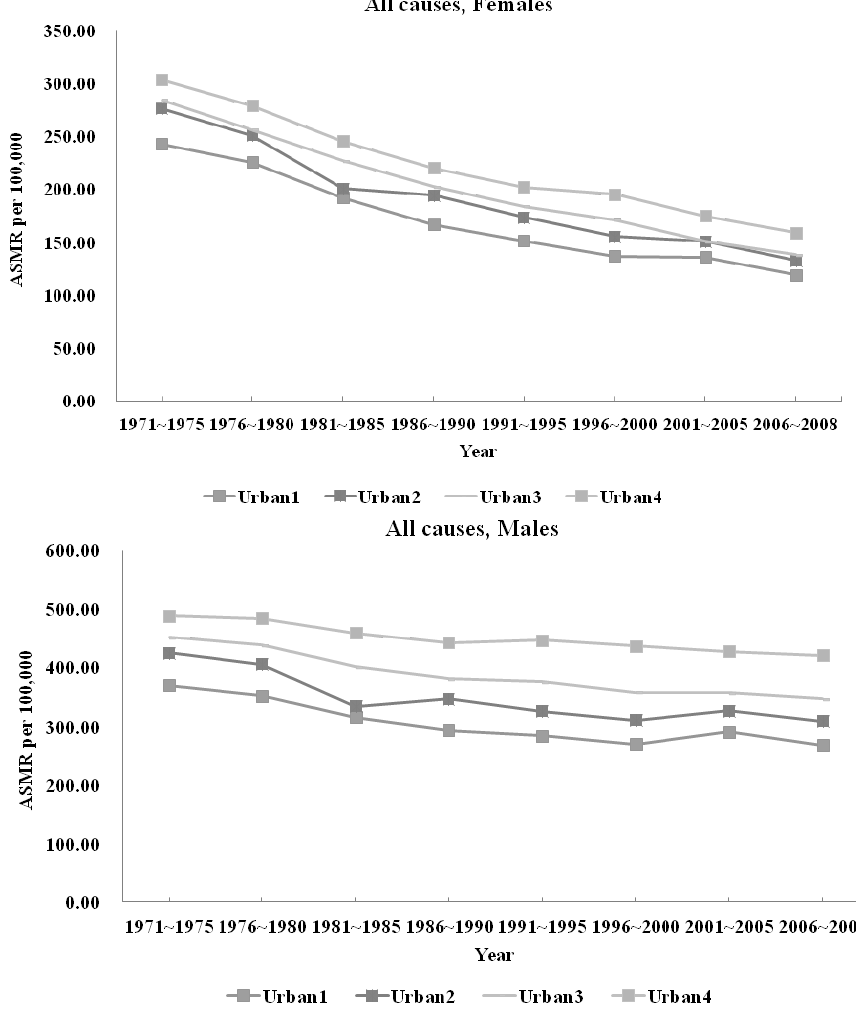
Figure 1. All cause mortality by urbanization level (Top: females; bottom: males).